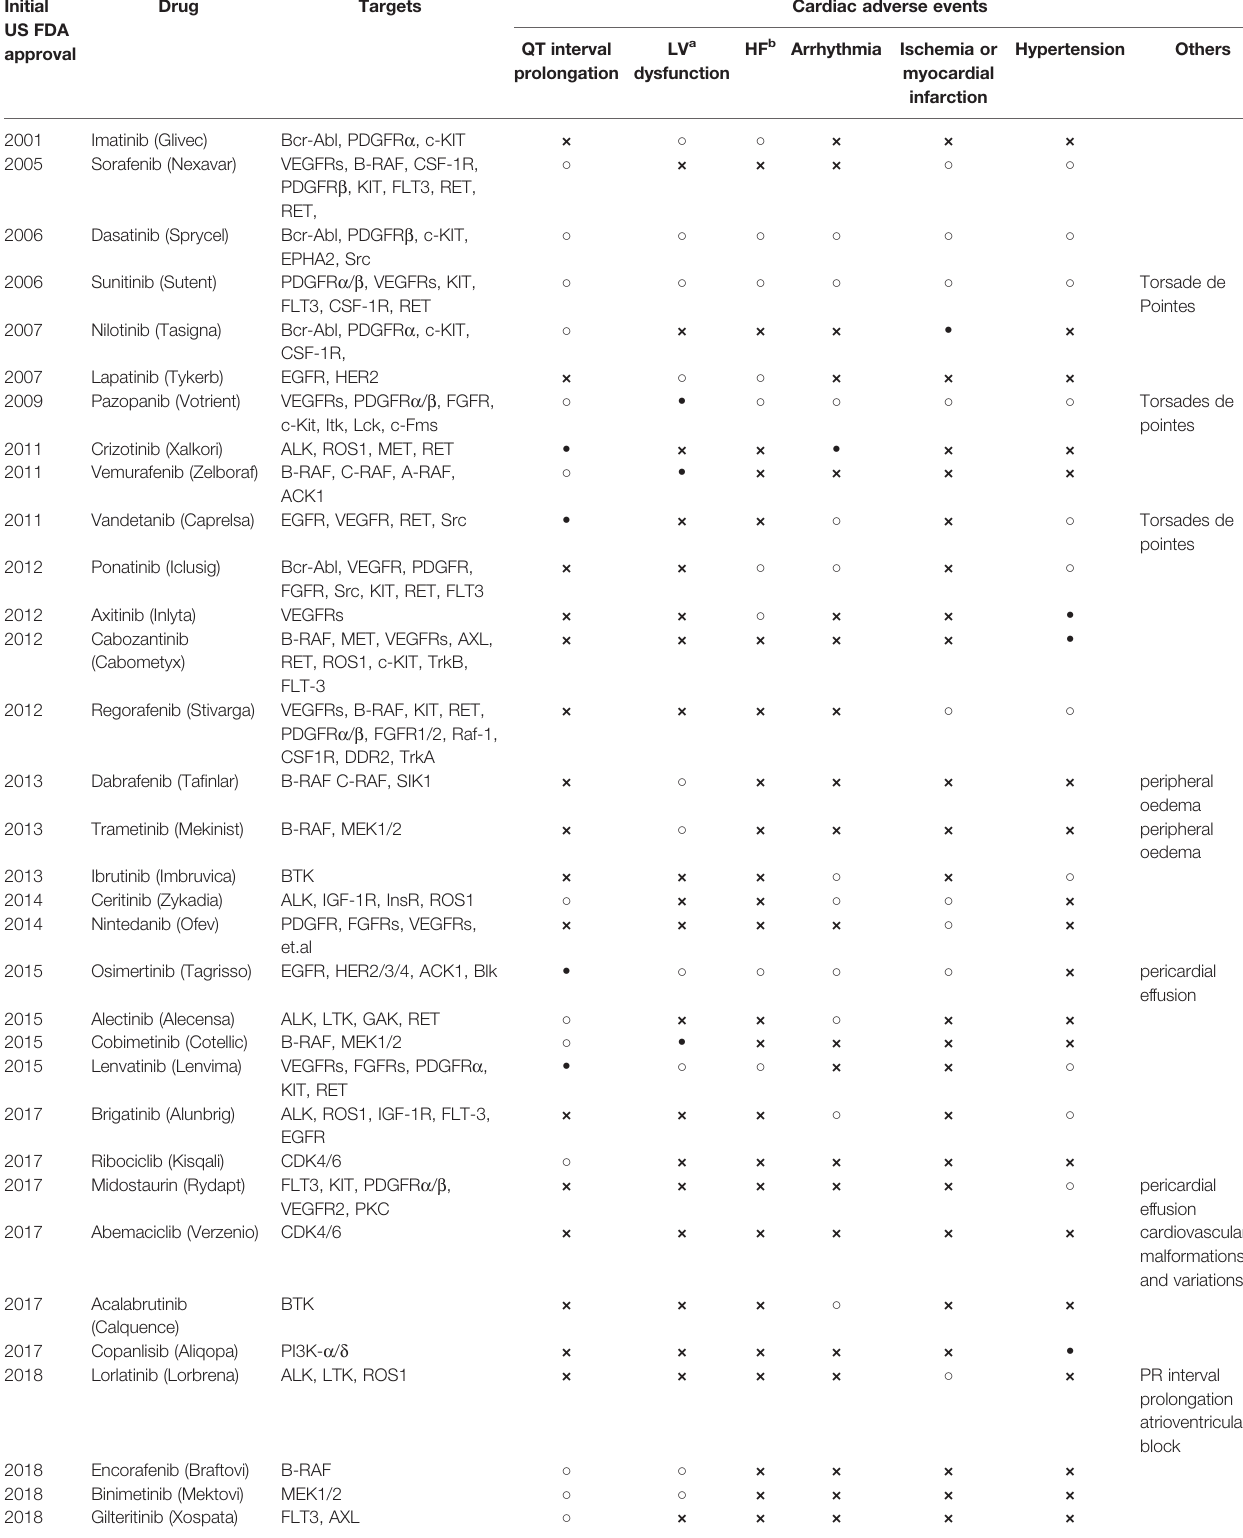
TABLE 1 | Cardiac adverse events of SMKIs with